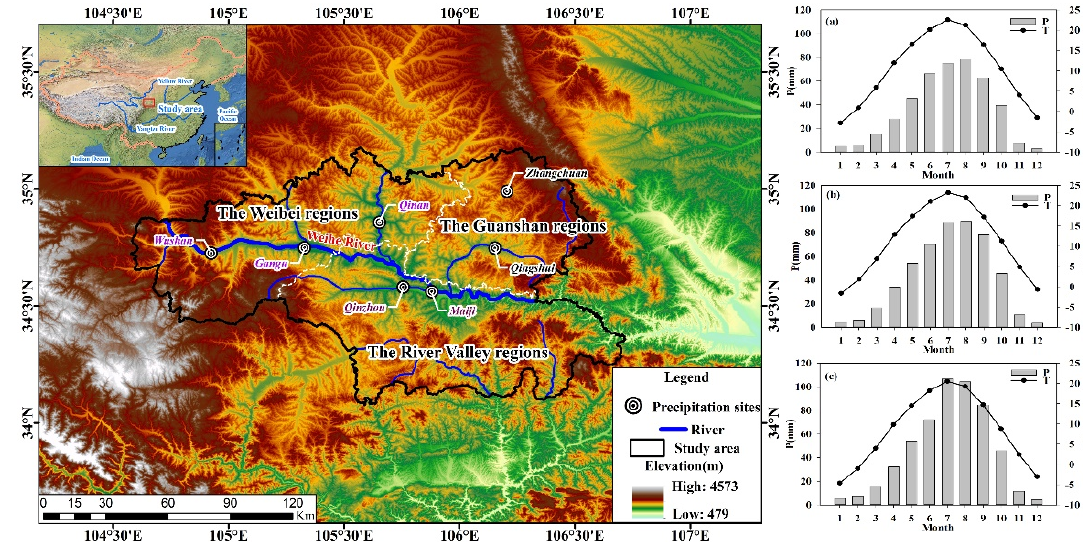
Figure 1. The three natural subregions of the sampling sites in the Tianshui area (marked using dashed white lines). Spatial distribution of altitude in the Tianshui area is derived from China 30 Arc-Second Elevation (GDEMV2; http://www.gscloud.cn/). The satellite-derived land cover base map is from Natural Earth (http://www.naturalearthdata.com). ( a – c ) Monthly mean air temperatures (T) and total precipitation (P) at the Weibei, the River Valley and the Guanshan regions. The line represents air temperature (T) and histogram represents precipitation (P).